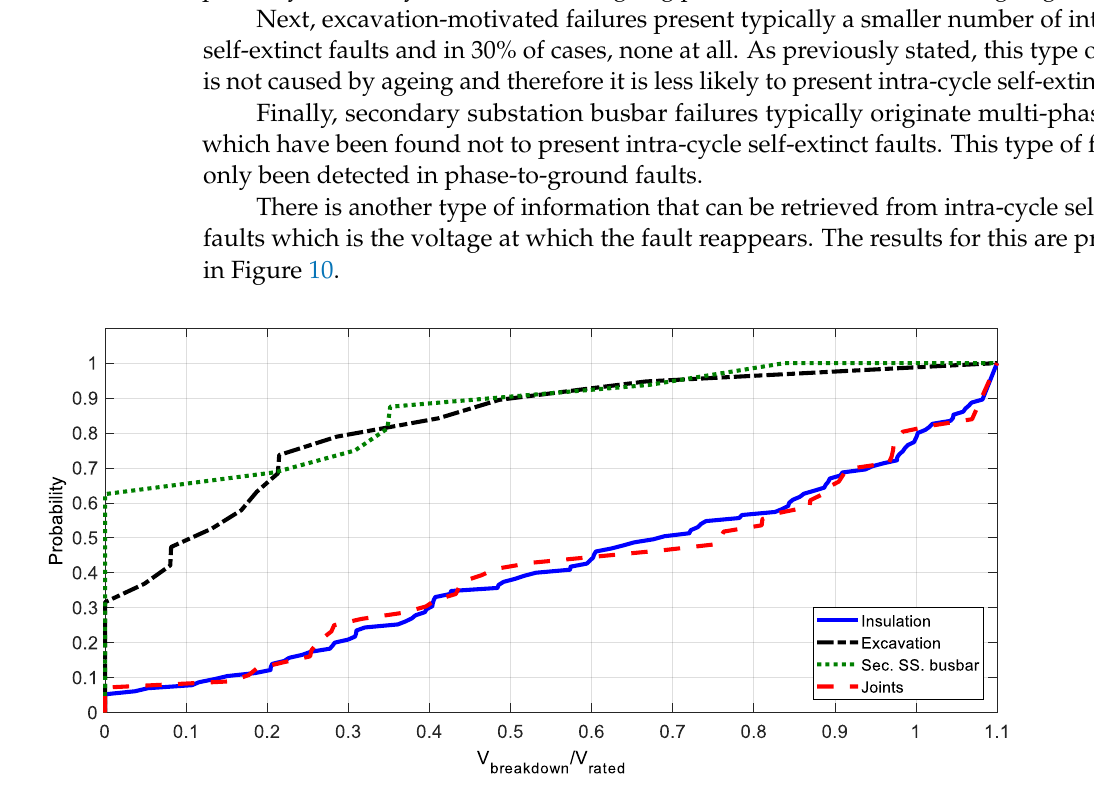
Figure 10. Observed cumulative probability for intra-cycle self-extinct fault breakdown voltage.